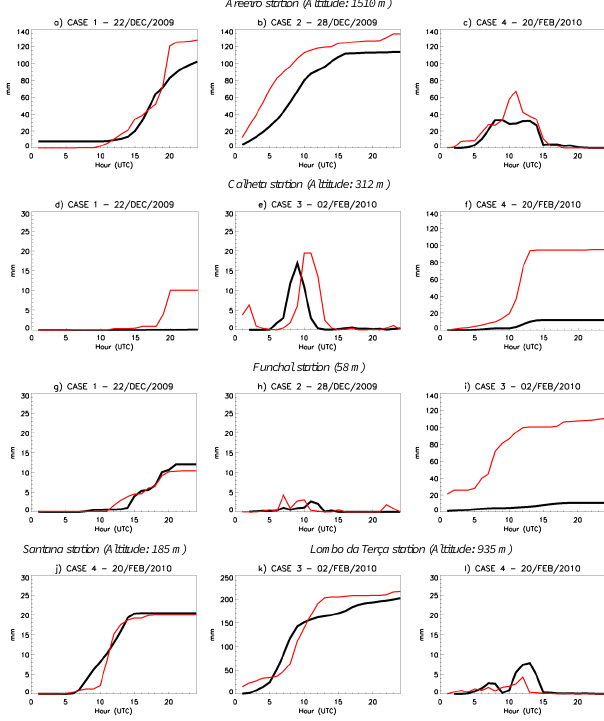
Figure 6. Comparison between the temporal evolution of hourly precipitation (HP) and 2 Fig. 6. Comparison between the temporal evolution of hourly pre- accumulated precipitation (AP), both measured (red) and simulated (black) for: Areeiro station (a) 3 cipitation (HP) and accumulated precipitation (AP), both measured AP on 22/DEC, (b) AP on 28/DEC, (C) HP on 20/FEB; Calheta station (d) AP on 22/DEC, (e) HP 4 (red) and simulated (black) for: Areeiro station (a) AP on 22 De- on 02/FEB, (f) AP on 20/FEB; Funchal station (g) AP on 22/DEC, (h) HP on 28/DEC, (i) AC on 5 cember, (b) AP on 28 December, (c) HP on 20 February; Calheta 02/FEB; Santana station (j) AP on 20/FEB; Lombo da Terça (k) AP on 02/FEB, and (l) HP on 6 station (d) AP on 22 December, (e) HP on 02 February, (f) AP on 20/FEB. 7 20 February; Funchal station (g) AP on 22 December, (h) HP on 28 December, (i) AP on 02 February; Santana station (j) AP on 20 February; Lombo da Terc¸a (k) AP on 02 February, and (l) HP on 20